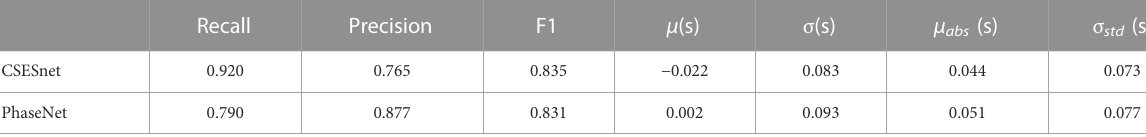
TABLE 3 Comparison of the performances of CSESnet and PhaseNet in